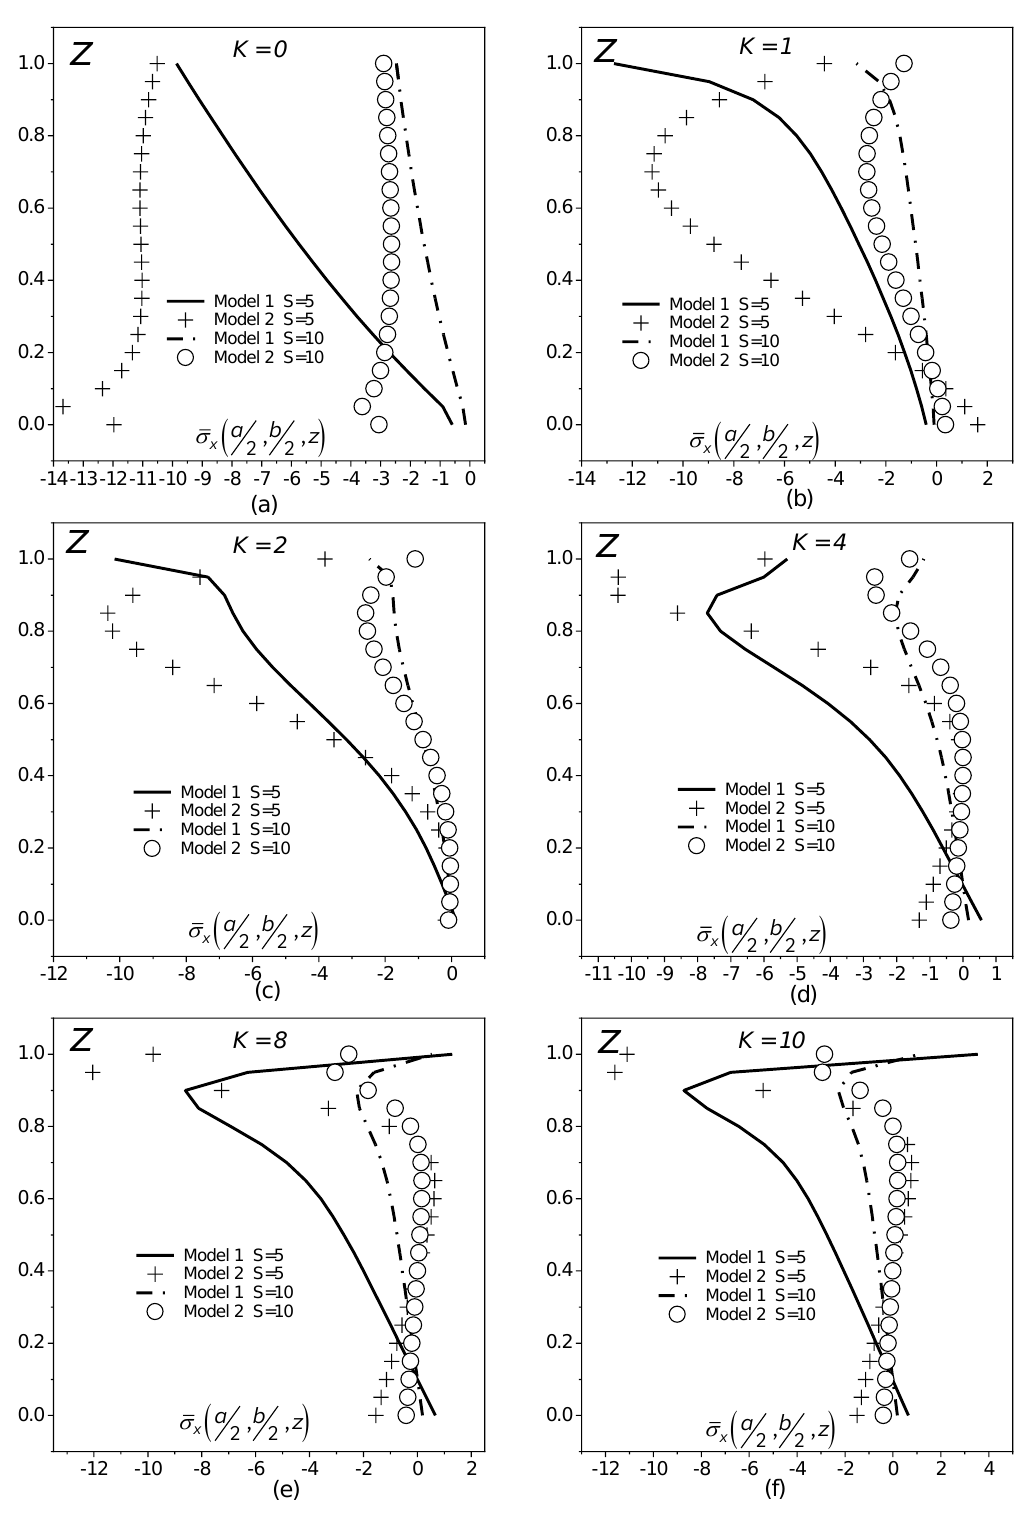
 ) for different material graded FG x square laminate for material set